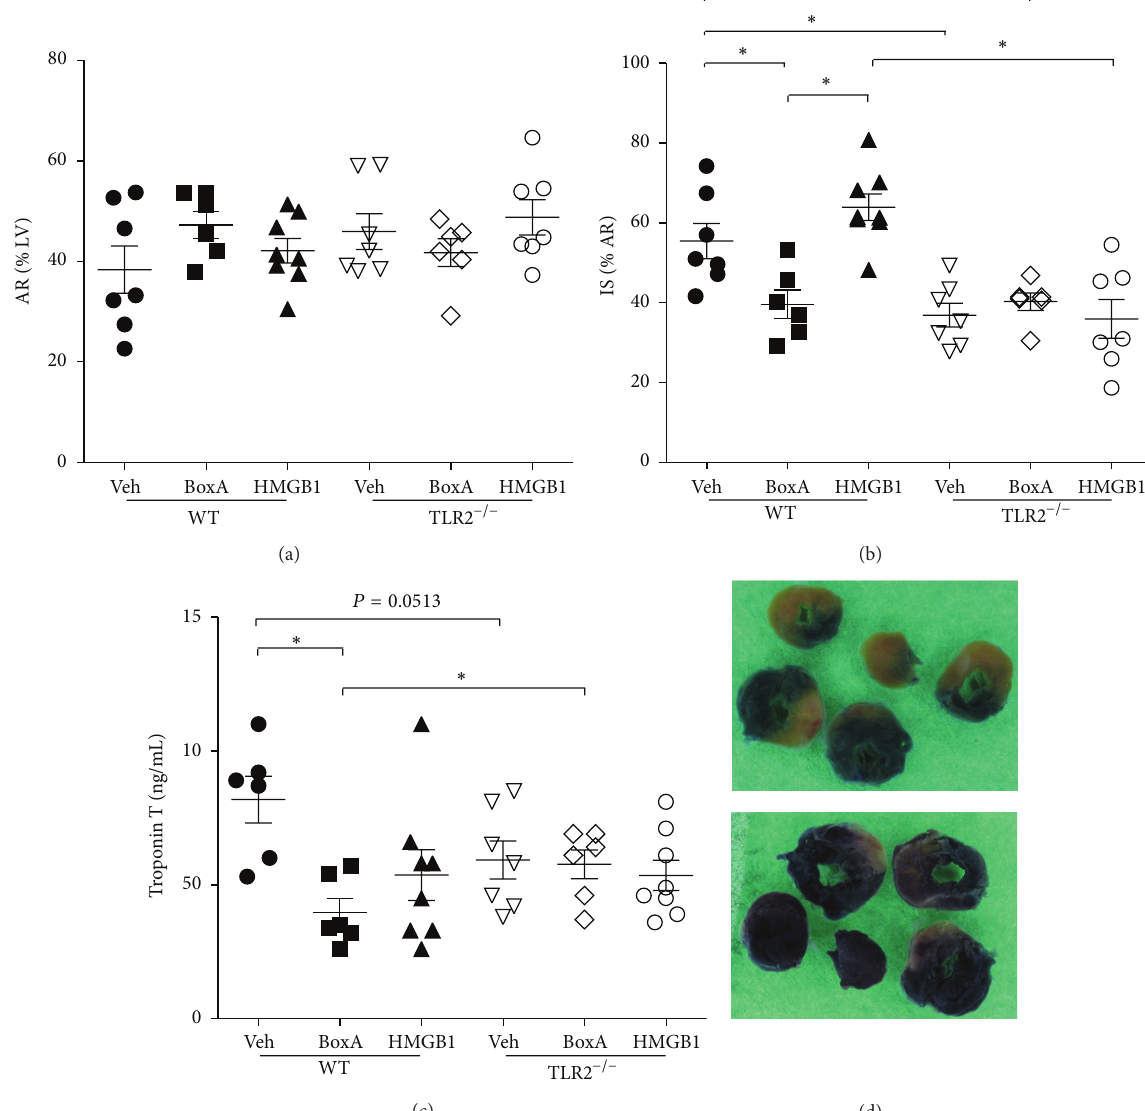
Figure1:Quantificationofmyocardialdamageafterischemia(30